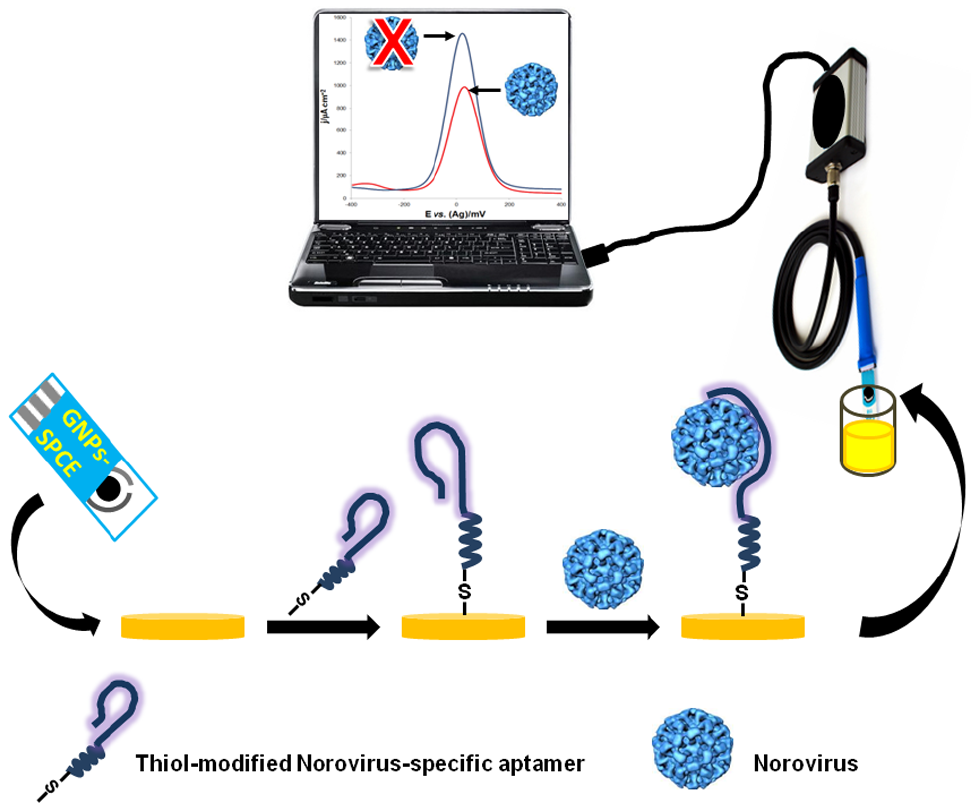
Figure 1. Schematic diagram of the electrochemical detection protocol adopted in this study. A thiolated norovirus-specific DNA aptamer was self-assembled onto a gold nanoparticles-modified screen-printed carbon electrode (GNPs-SPCE). Binding of the virus to the immobilized aptamer causes a decrease in the redox current, measured via square wave voltammetry.